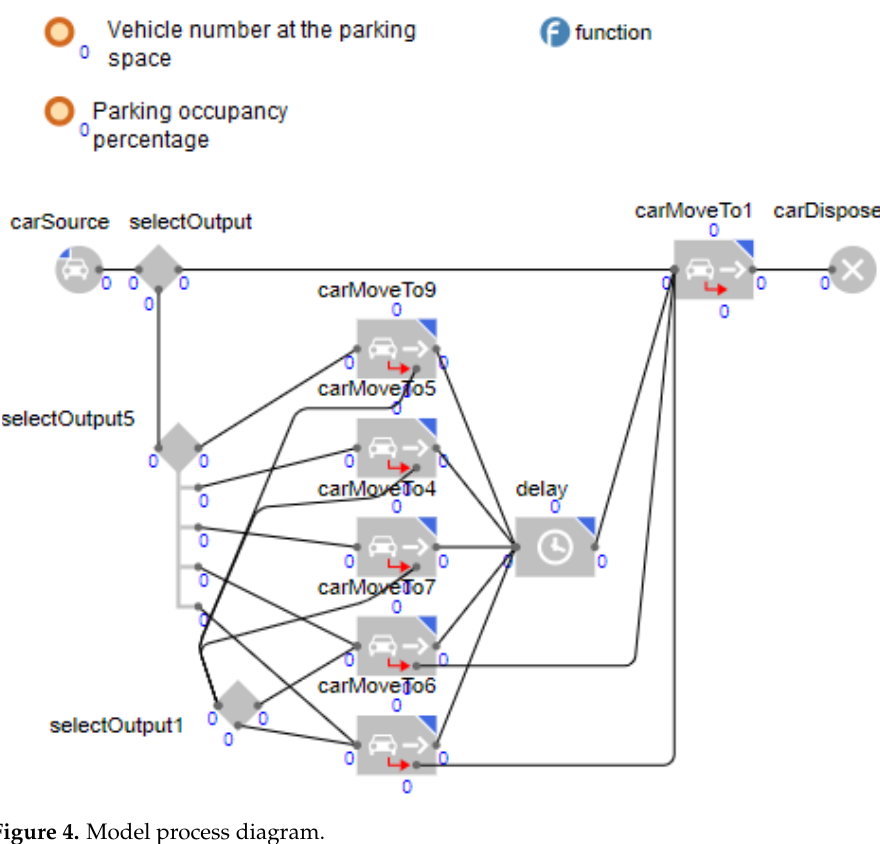
Figure 4. Model process